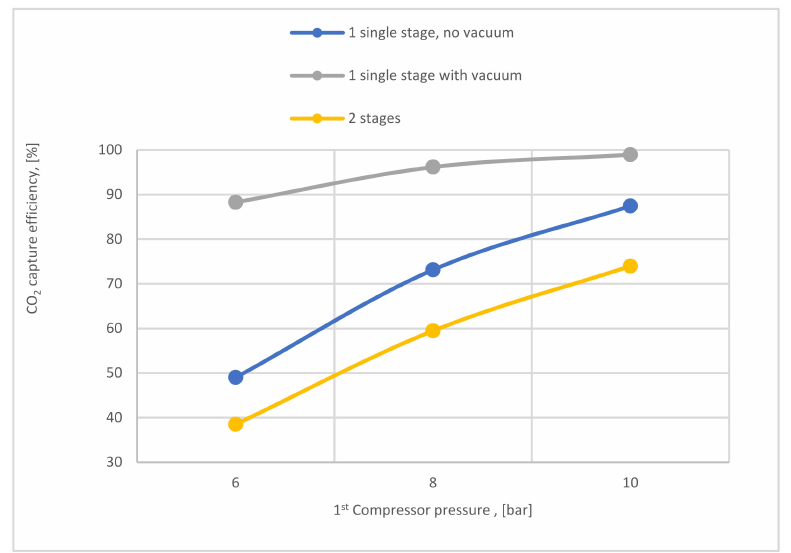
Figure 20. CO 2 capture efficiency variation at 200,000 m 2 of SA 1 , 0.25 bar of VP pressure, CP 2 of 4 bar, and SA 2 of 20,000 m 2 based on different 1st compressor